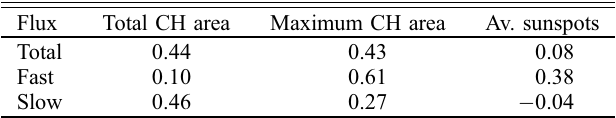
Table 1. Correlation coefficients between components of SW density flux, CH areas and daily sunspots numbers averaged over Carrington rotations.